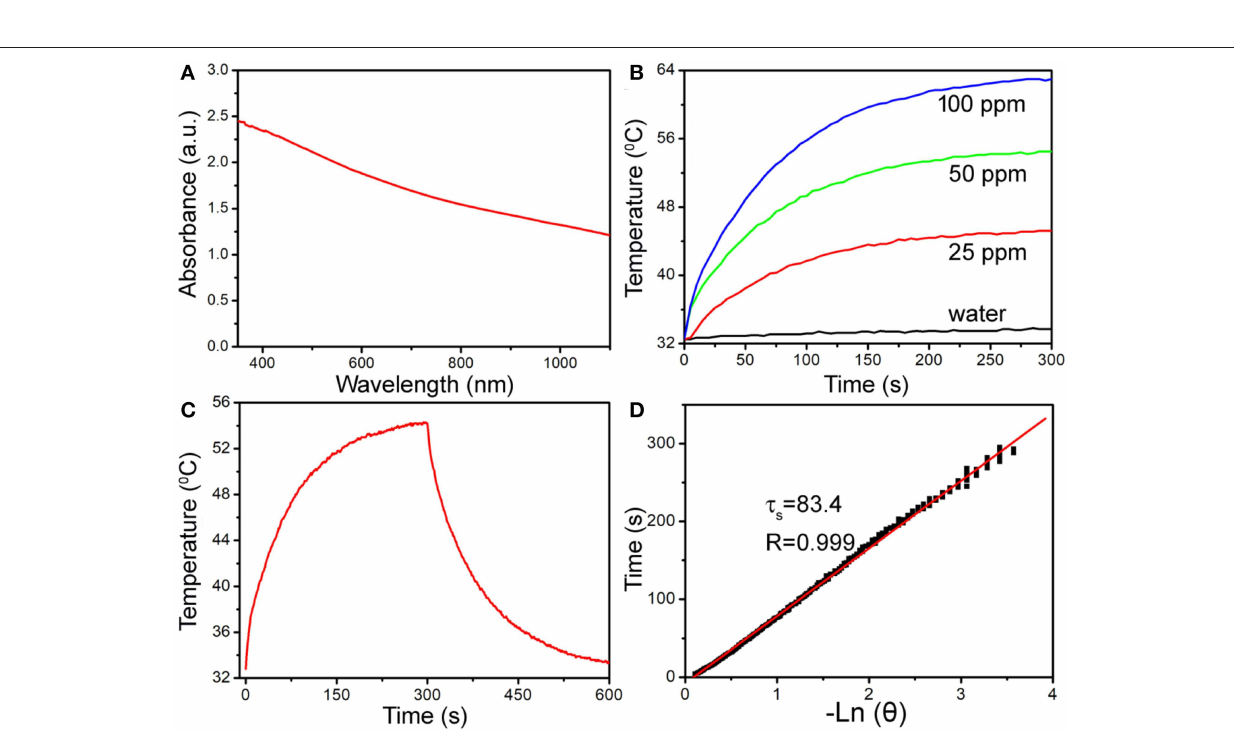
FIGURE 2 | (A) UV-vis-NIR absorbance spectrum of CMO NCs dispersed in water. (B) Temperature change of CMO NCs in water at various Mn 2 + concentrations (i.e., 0, 25, 50, and 100 ppm) as a function of irradiation time. (C) Photothermal effect of CMO NCs (50 ppm). (D) Time constant of CMO NCs from the system. The laser is an 808nm laser with a power of 189